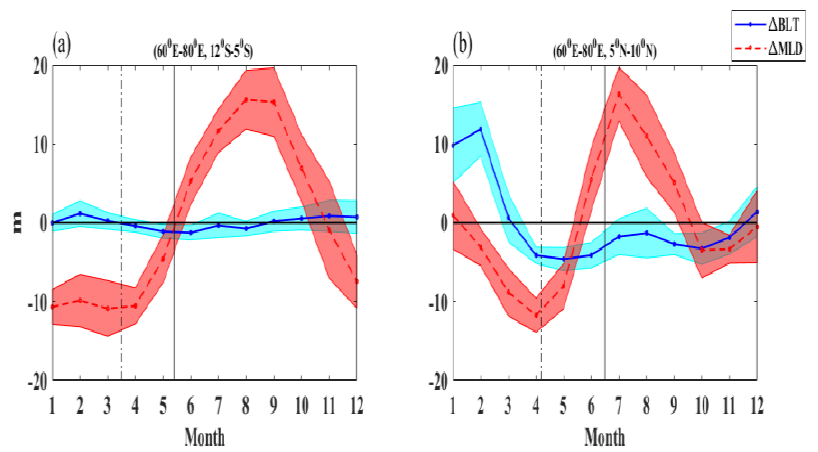
Figure 5. Seasonal variability for both BLT (in blue) and MLD anomalies (in red) in the areas [( a ); 60 ◦ E–80 ◦ E, 10 ◦ S–5 ◦ S] and [( b ); 60 ◦ E–80 ◦ E, 5 ◦ N–10 ◦ N] for 2005 to 2014 (The shaded areas are the standard deviation, the solid black line represents the time that SSSAs change and dotted black line represents the time that the tendency of SSSAs change). Unit: m.